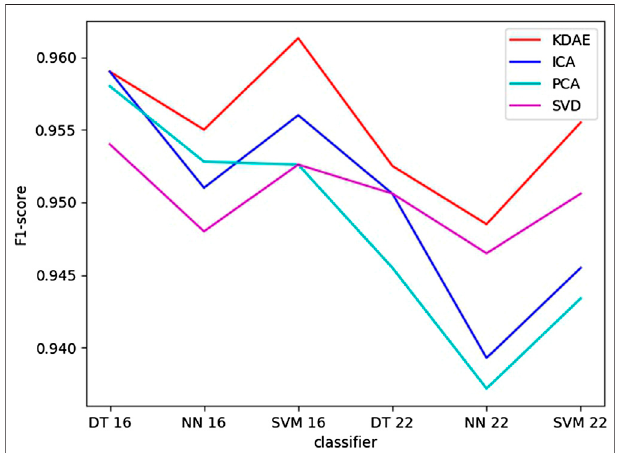
FIGURE 5 | The comparison of F1 Score with different dimension reduction